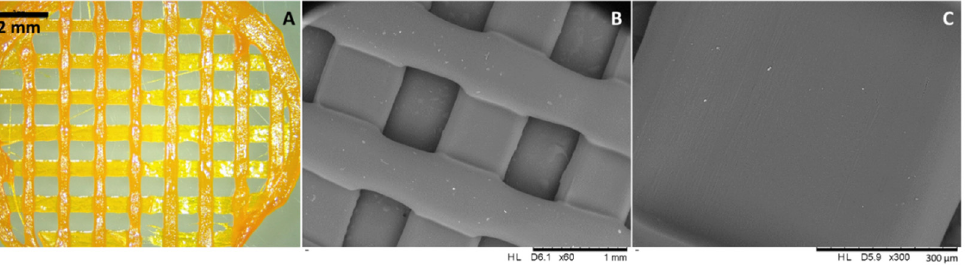
Figure 3. Digital microscopy ( A ) and SEM ( B , C ) images with different magnification of the drug- loaded 3D-printed meshes.